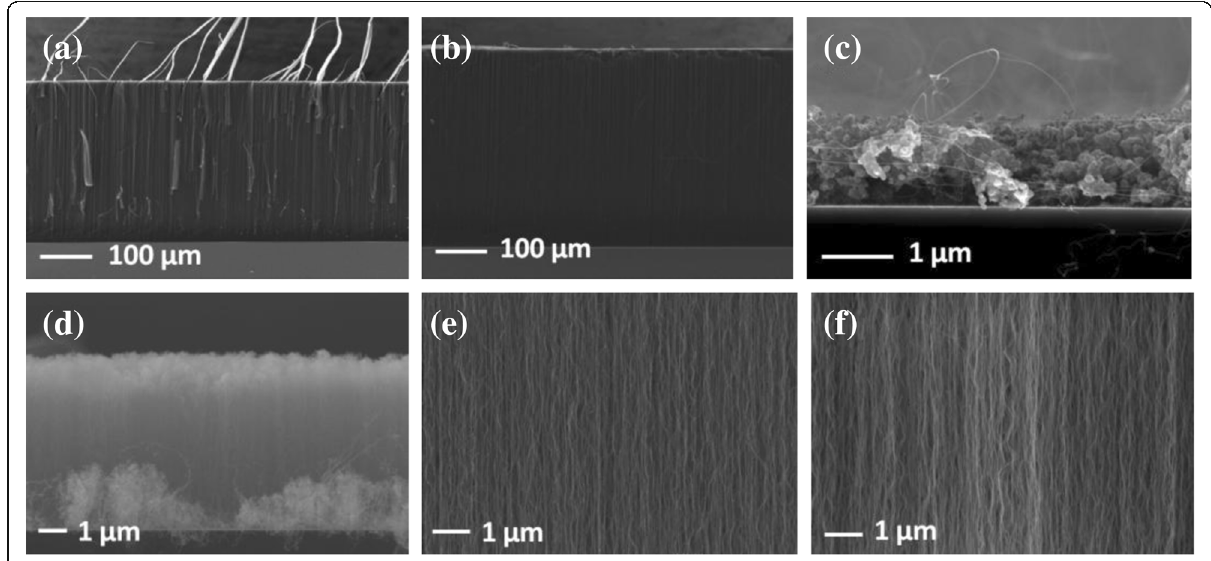
Fig. 3 Cross-sectional SEM images of VACNTs grown on different buffer layers at 600 °C: a ALD Al 2 O 3 , b EB Al 2 O 3 , c sputtered Al 2 O 3 , and d SiO 2 . Images e and f show the internal structure of a and b at high